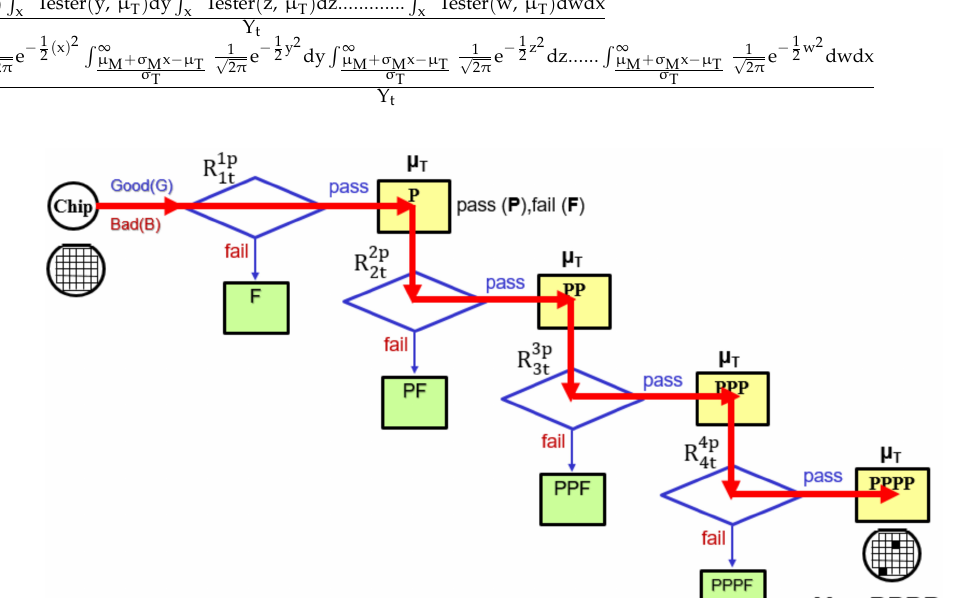
to improve test nt